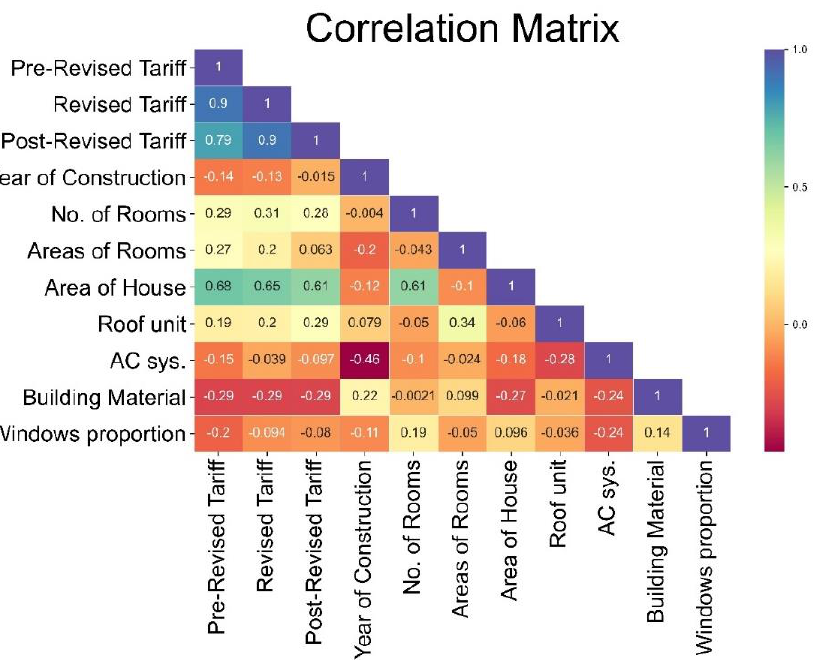
Figure 10. Correlation between input variables in determining the energy consumed in the form of a correlation matrix.